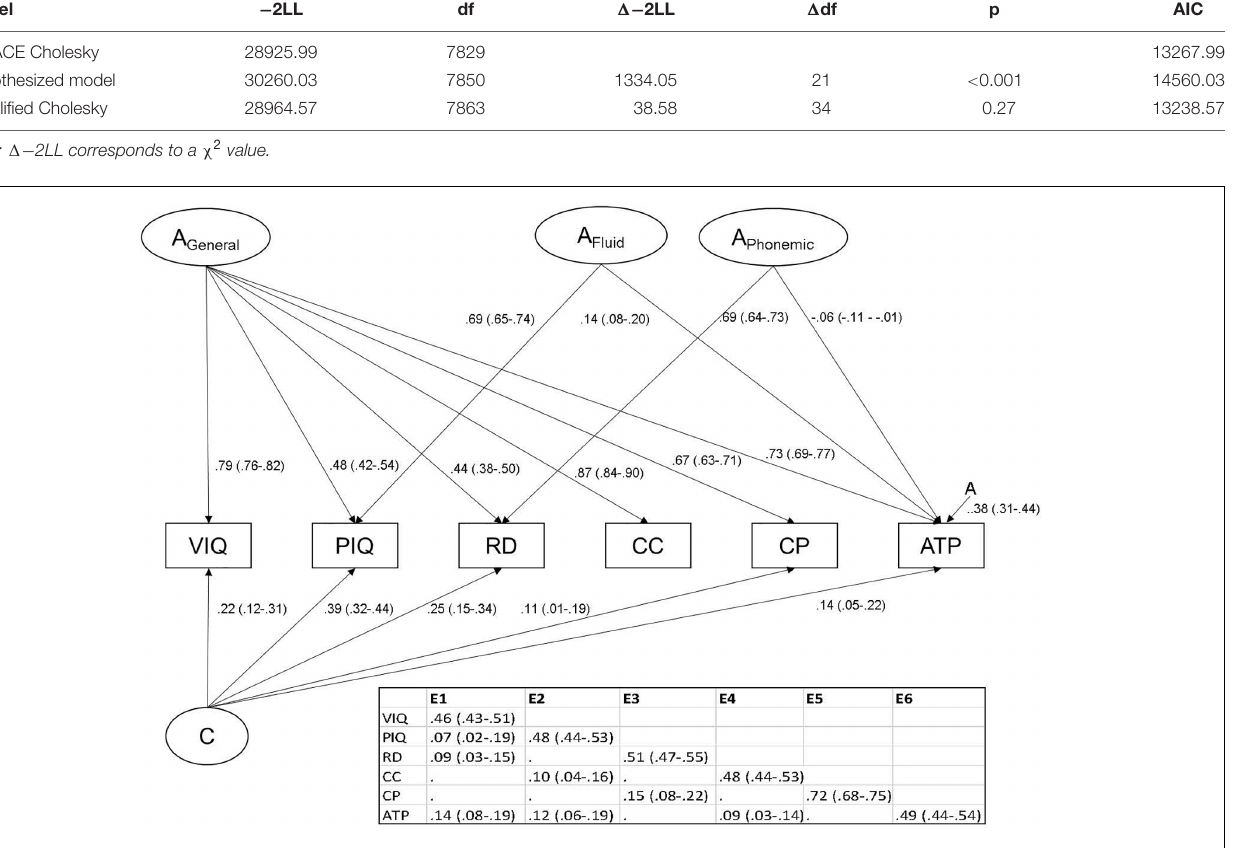
FIGURE 2 | Path diagram showing significant standardized loadings with 95% confidence intervals (ML) of final reduced model. A General represents general additive genetic effects, A Fluid represents fluid ability genetic effects, A Phonemic represents phonological reading additive genetic effects. A represents specific additive genetic effects. The unique environmental (E) structure is presented in the table. VIQ, verbal IQ; PIQ, performance IQ; RD, reading; CC, comprehend and collect; CP,